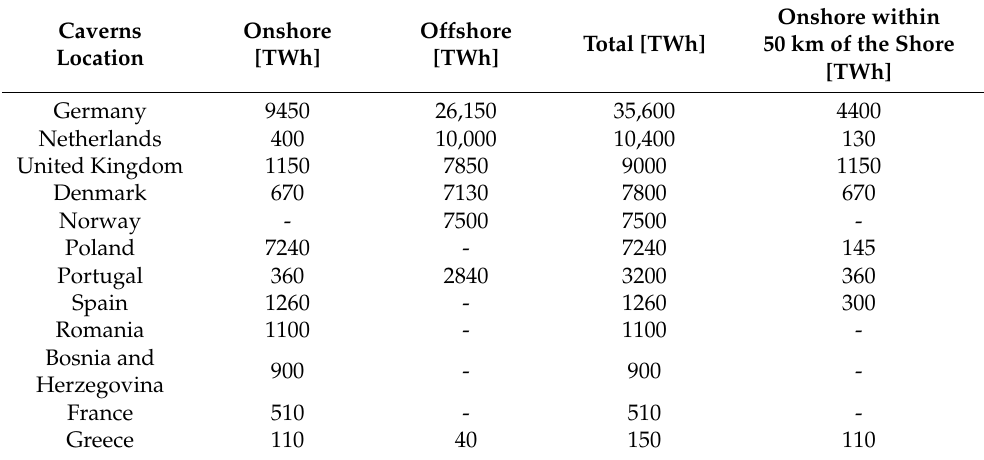
Table 1. Cavern storage potential for European countries onshore, offshore, and within 50 km of shore (based on Figure 7 from